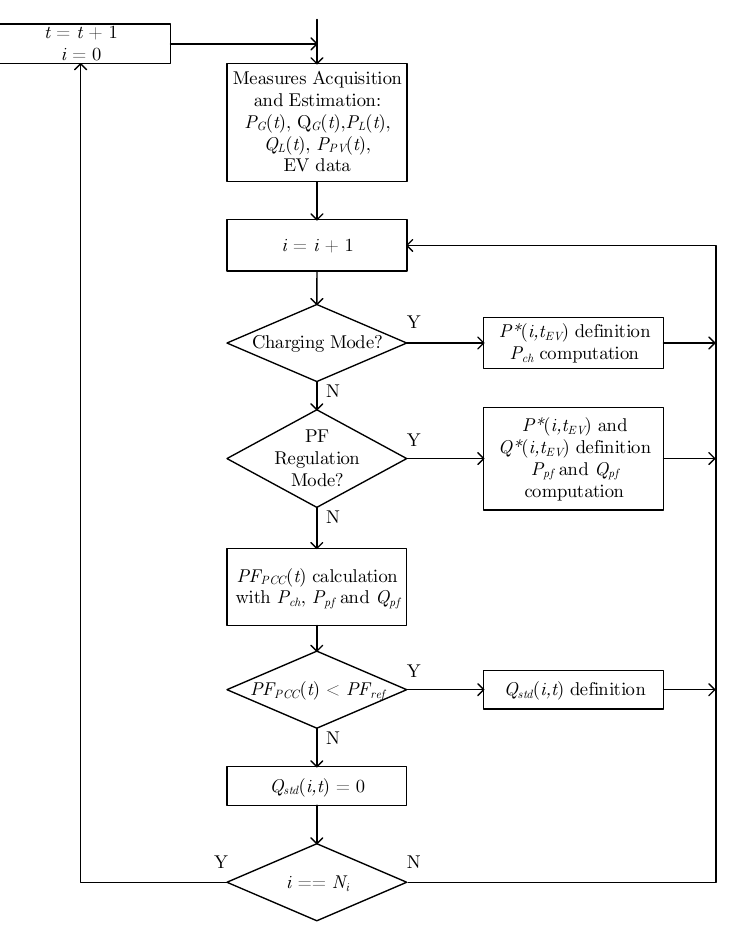
Figure 7. Flowchart of the microgrid management